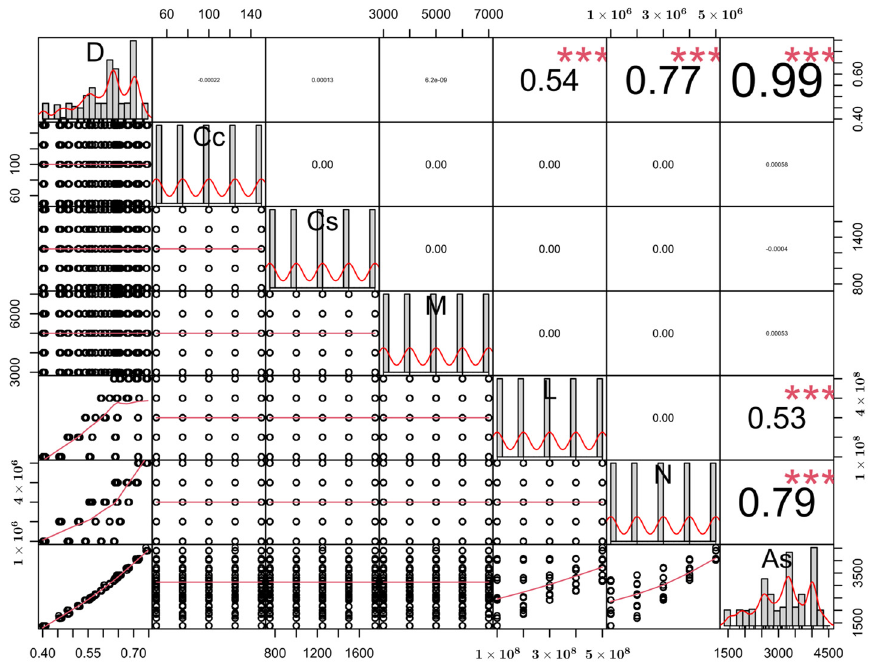
Figure 4. Correlation matrix of the dataset.